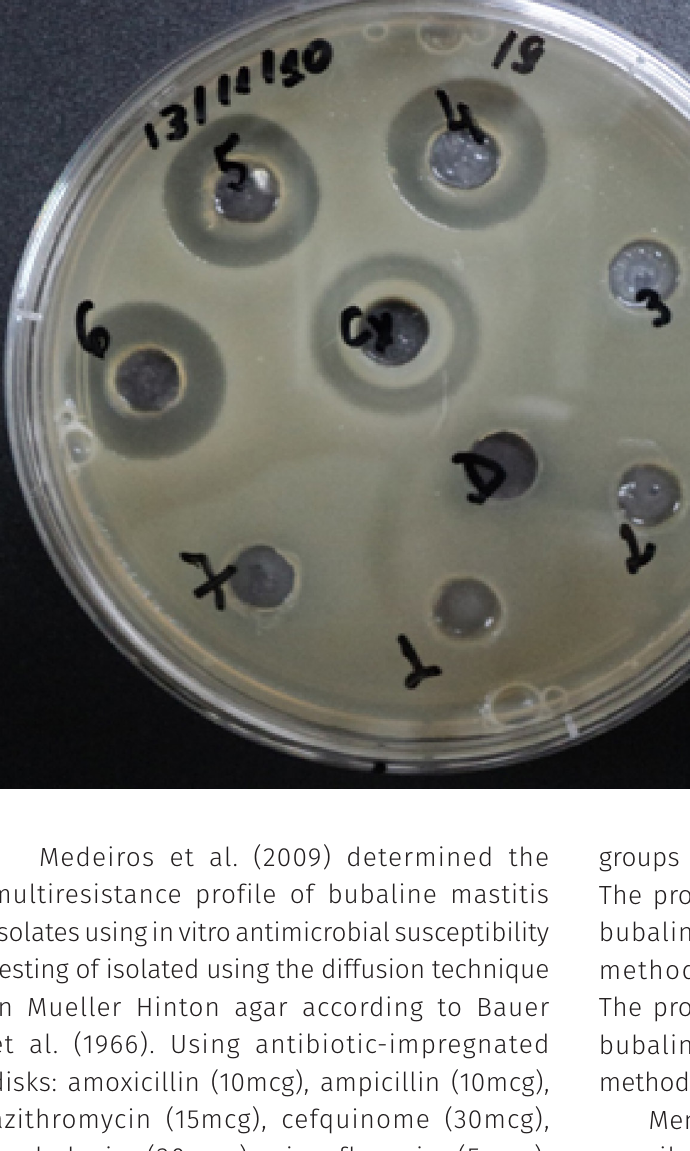
Figure 2. Illustrative picture of the microbial growth inhibition halos against S. buffalo mastitis S.aureus after diffusion test using the copaiba oil. Wells: